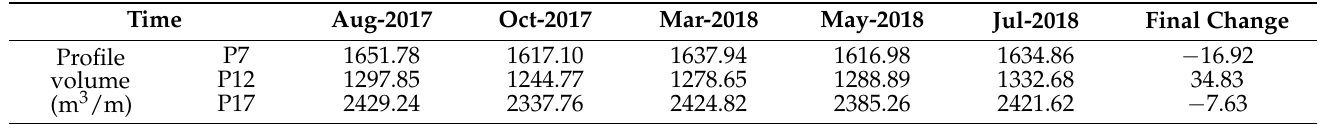
Figure 7. Shoreline migrations from October 2017 to July 2018 relative to the baseline of August 2017. Table 1. Profile volumes of P7, P12 and